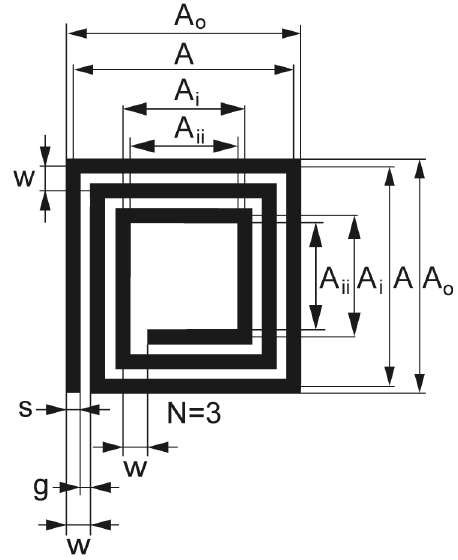
Figure 1: The layout of a square planar spiral coil of three windings ( 𝑁 = 3 ) with its design